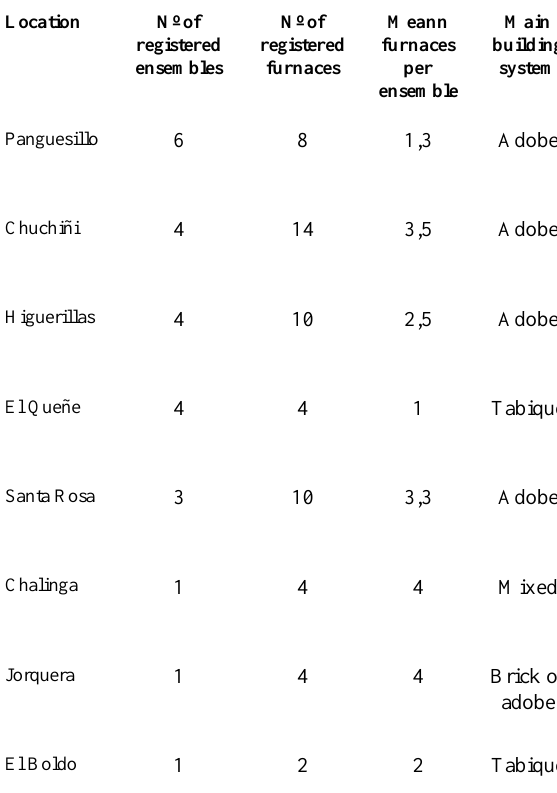
Table 1. Main building systems and ratio of furnaces per ensemble in each studied